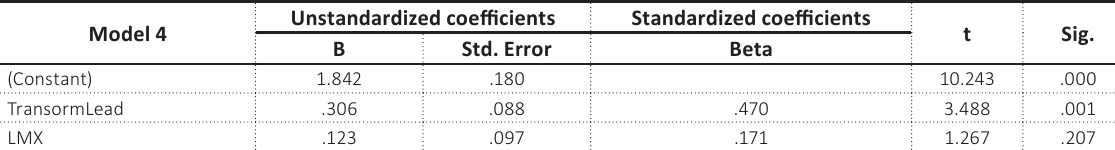
Table 9. Mediator effect of LMX between transformational leadership and OC Model 4